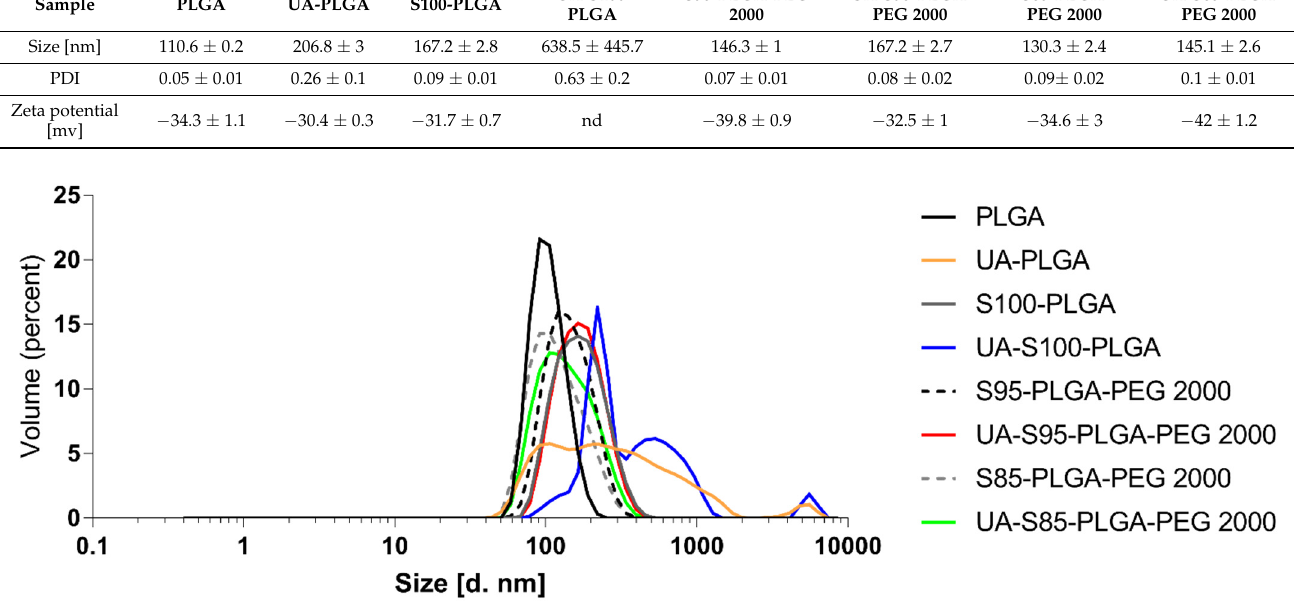
Figure 2. Size distribution of the tested nanoparticles.